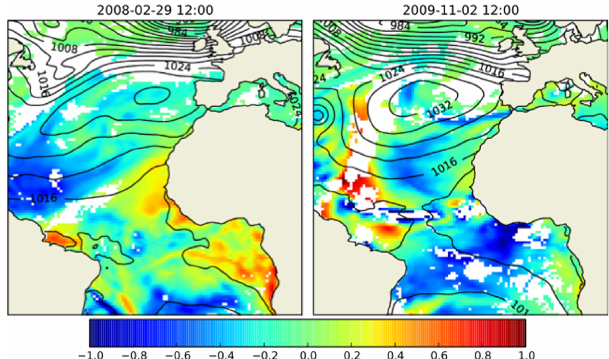
Figure 4. Simulation of locally correlated errors in the retrieval of sea surface temperature (SST) overlaid with surface pressure con- tours to indicate length scales of atmospheric variability. The sim- ulated retrieval errors are for a noise-free sensor with a calibration that is perfectly known. The errors therefore arise solely from intrin- sic ambiguity in inverting the observed radiances to SST. Note that there is no simple relationship between the SST errors and the at- mospheric features associated with synoptic weather systems. The white areas indicate 100% cloud cover. Reprinted from Merchant and Embury (2014) with permission from Elsevier©